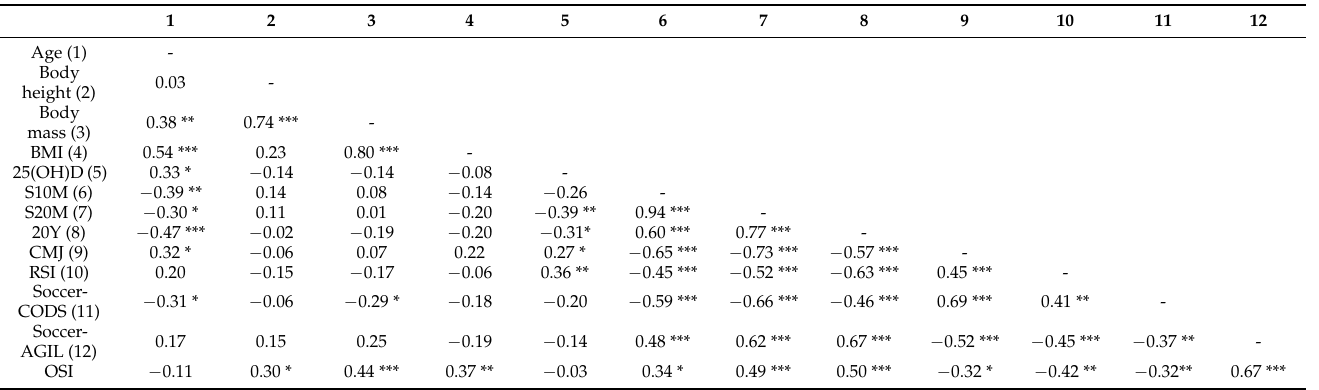
Table 3. Pearson’s correlation coefficients between study variables (*** p < 0.001, ** p < 0.01, * p <